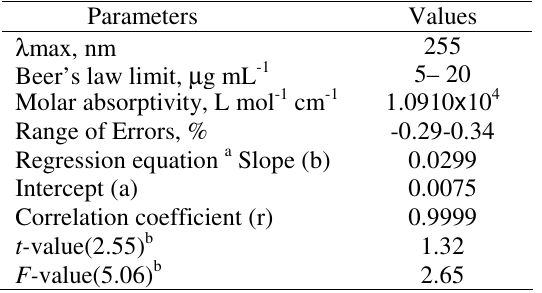
Table 1 . Parameters for determination of valacyclovir HCl against 0.1N HCl.